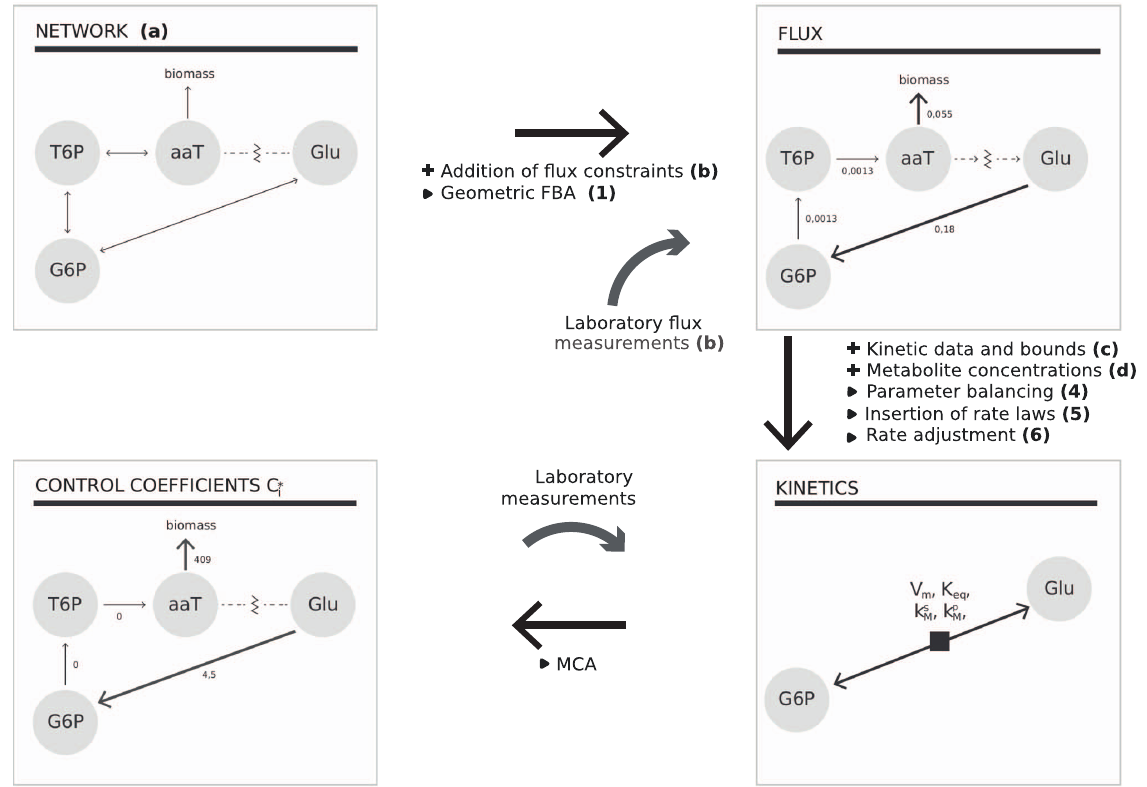
Figure 1. Stages of data addition ( + ) and method runs ([ . ]) in the workflow. Letters and numbers in parentheses refer, respectively, to input data and to the stages of the workflow. (1) Geometric FBA [32] is run, yielding a thermodynamically feasible, stationary flux distribution matching the flux data; (2) a sub-network of flux-carrying reactions is exported, (3) consistent values of all metabolite concentrations and equilibrium constants are determined, (4) kinetic constants appearing in the sub-network are balanced, (5) kinetic rate laws and associated kinetic constants are inserted into the model, and (6) the maximal reaction rates are adjusted to reproduce the steady-state fluxes calculated before. The laboratory data feeding into ‘‘Flux’’ can include quantitative metabolomic measurements of metabolites, and also dynamically calculated flux values for the network. The lower half of the diagram shows a cycle of experimentation and modelling: here the result of the MCA can be used to target which rate laws should be measured in vitro after measurement, this rate law can be substituted into the model, with a view to better fit the observed perturbation behaviour. All grey arrows refer to aspects of the workflow where additional data can be added in as knowledge increases. The pathway shown is a truncated version of the trehalose pathway. Abbreviations: T6P=trehalose 6-phosphate; aaT= a - a trehalase; Glu=Glucose; G6P=glucose 6-phosphate.